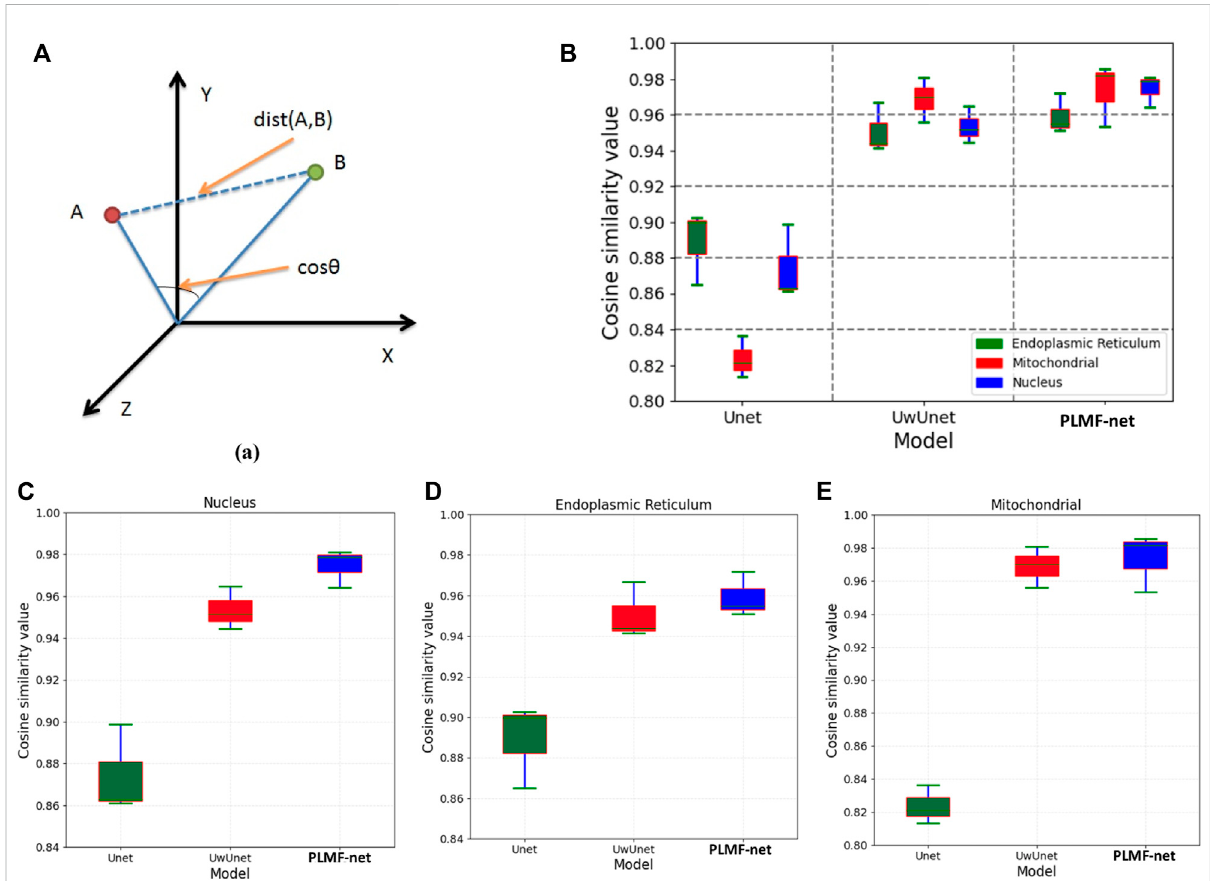
FIGURE 11 Comparison of the cosine correlation performance among various prediction algorithms. (A) The cosine correlation performance measures that are typical for predictive tasks. (B) The box plot of cosine similarity value over all organelle (nuclei, mitochondria, and endoplasmic reticuli) prediction task sets with the PLMFNet-based learning model and compared with that of varied deep neural network-based prediction models such as Unet and UwUnet learning models. (C) The box plot of cosine similarity value on the nuclei prediction task set with the PLMFNet-based learning model and comparedwith that of varied deep neural network-based prediction models such as Unet and UwUnet learning models. (D) The box plot of cosine similarity value on endoplasmic reticuli prediction task set with PLMFNet-based learning model and compared with that of varied deep neural network-based prediction models such as Unet and UwUnet learning models. (E) The box plot of cosine similarity value on the mitochondria prediction task set with the PLMFNet-based learning model and compared with that of varied deep neural network-based prediction models such as Unet and UwUnet learning models.